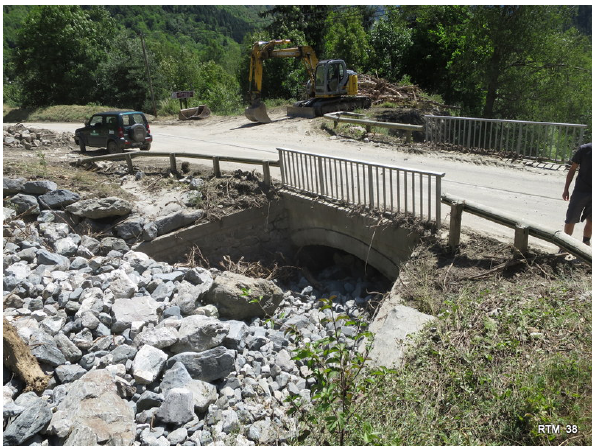
Figure 2. Effect of a sediment pulse at a bridge section of the Ruis- seau de la Gorge (France), a stream that was known by local en- gineers as having been inactive for decades. The transported mate- rial was much finer ( D 50 = 96mm, D 84 = 169mm) than the bed in place ( D 50 = 250mm, D 84 =